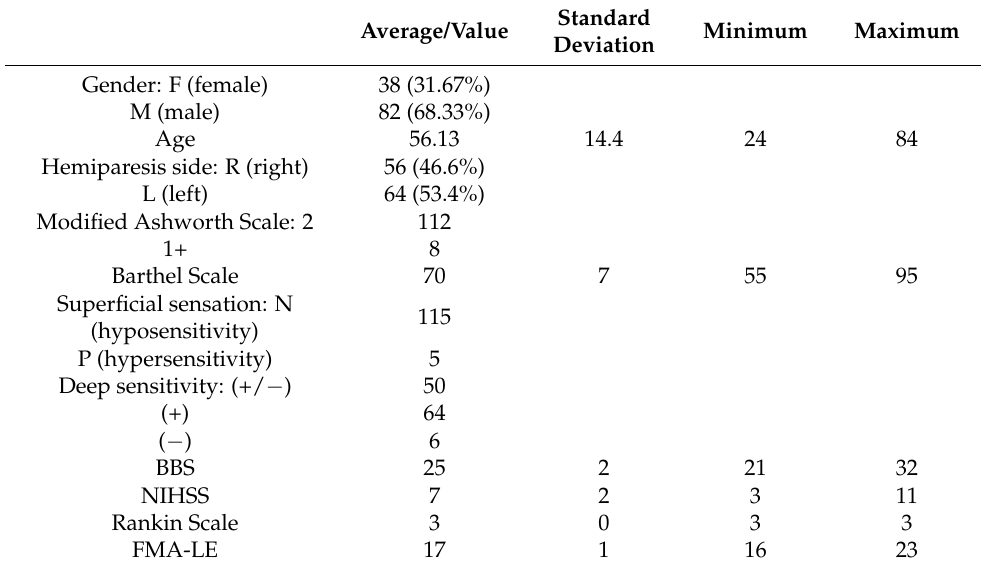
Table 2. Demographic and functional characteristics of the study participants.